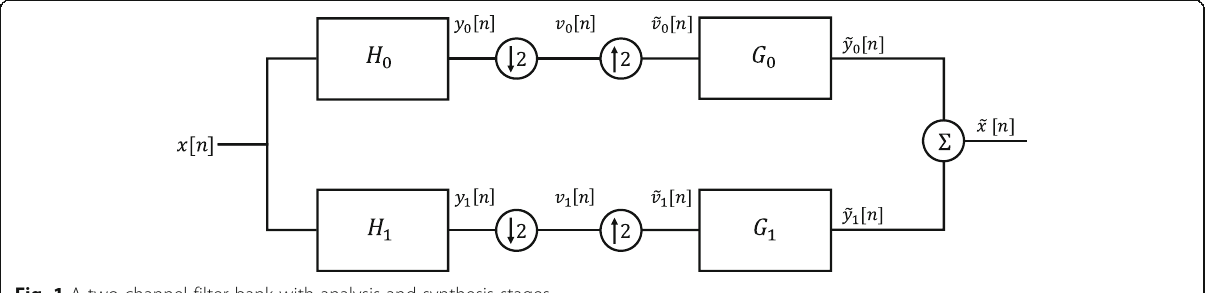
Fig. 1 A two-channel filter bank with analysis and synthesis